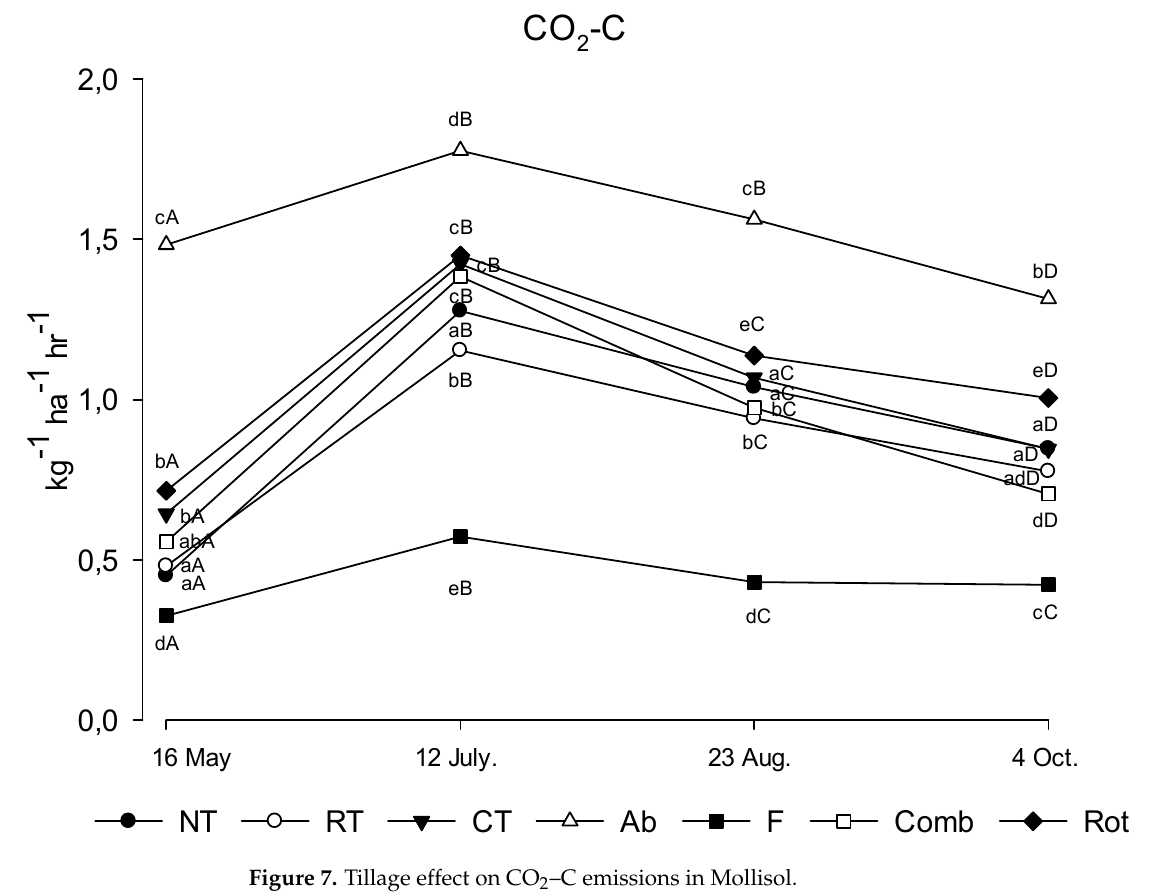
Figure 7. Tillage effect on CO 2 –C emissions in Mollisol.